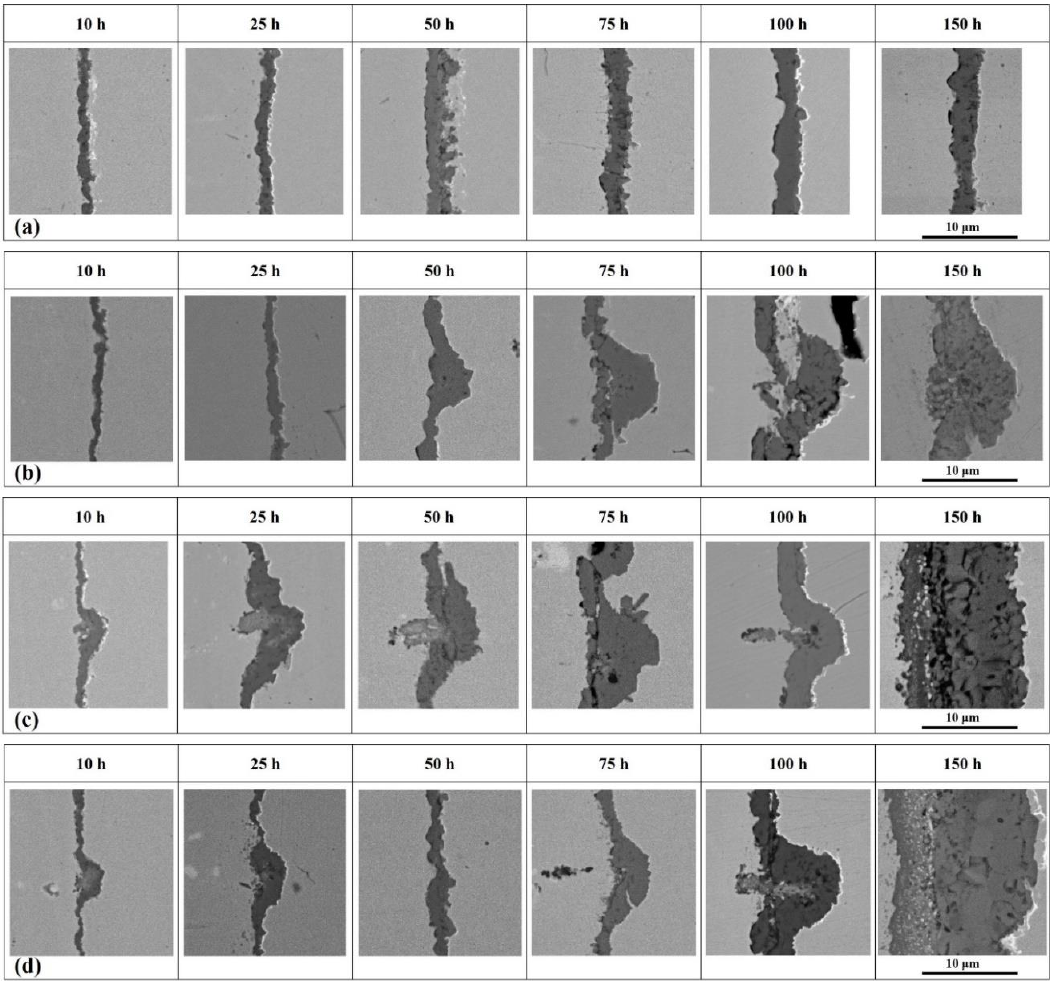
Figure 4. Optical micrograph of the oxide layer as a function of annealing time in 22Cr25NiWCoCu stainless steels with Nb contents of ( a ) 0, ( b ) 0.29, ( c ) 0.58, and ( d ) 0.86 wt.%.